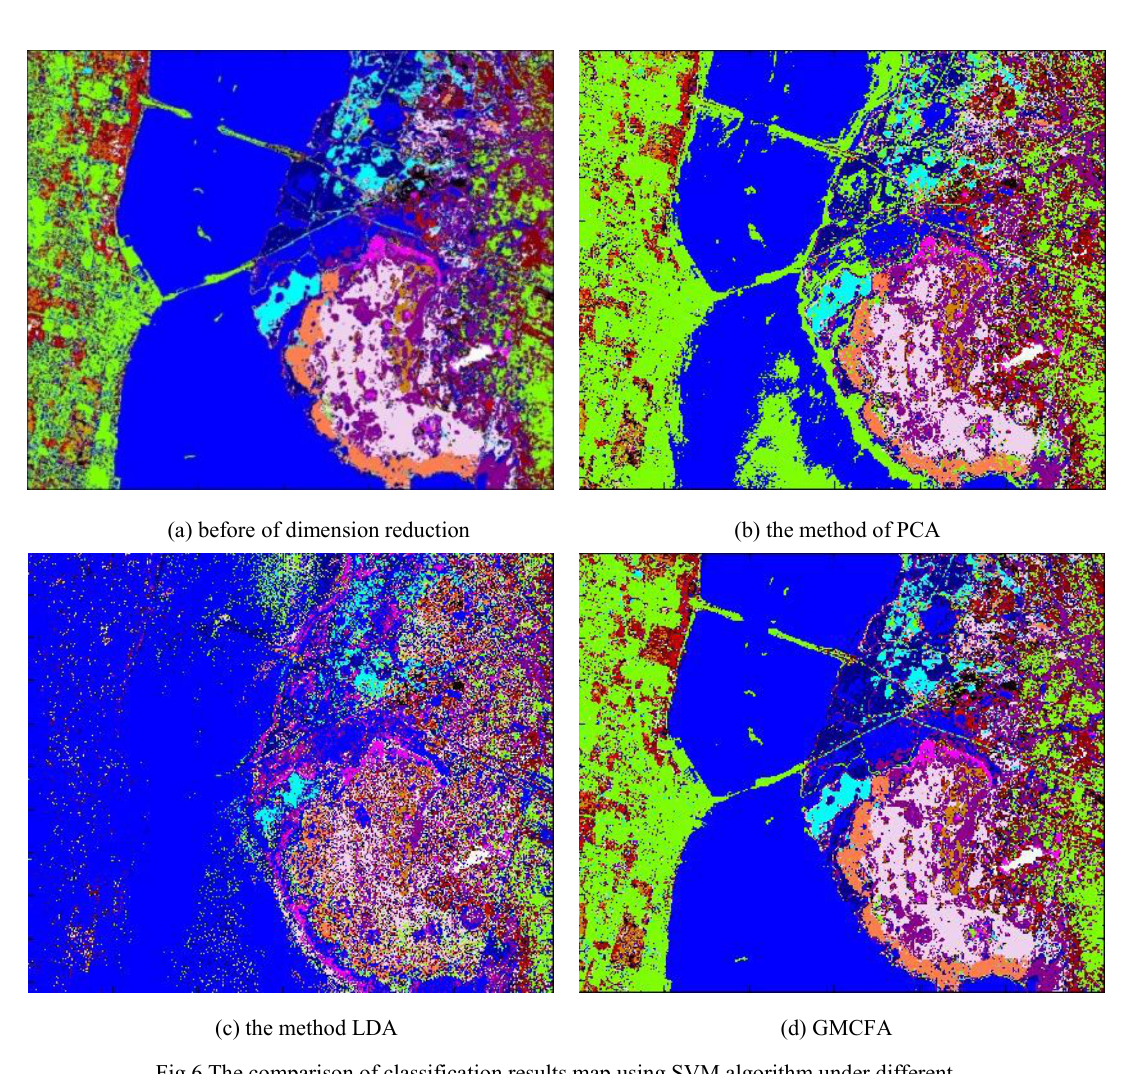
Fig.6 The comparison of classification results map using SVM algorithm under different dimension reduction algorithm of AVIRIS